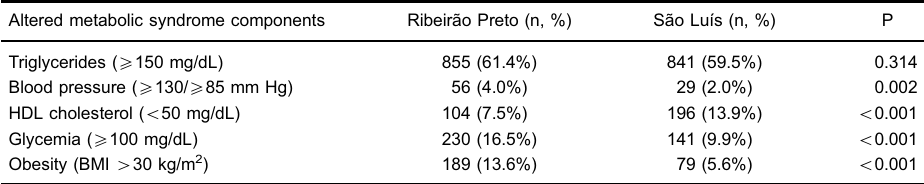
Table 4. Biochemical pro fi le of pregnant women in Ribeirão Preto and São Luís 2010 birth cohorts. Biochemical pro fi le (mg/dL) Ribeirão Preto São Luís P n Mean SD Total Cholesterol 1393 LDL Cholesterol HDL Cholesterol Triglycerides 1393 Glycemia 1393